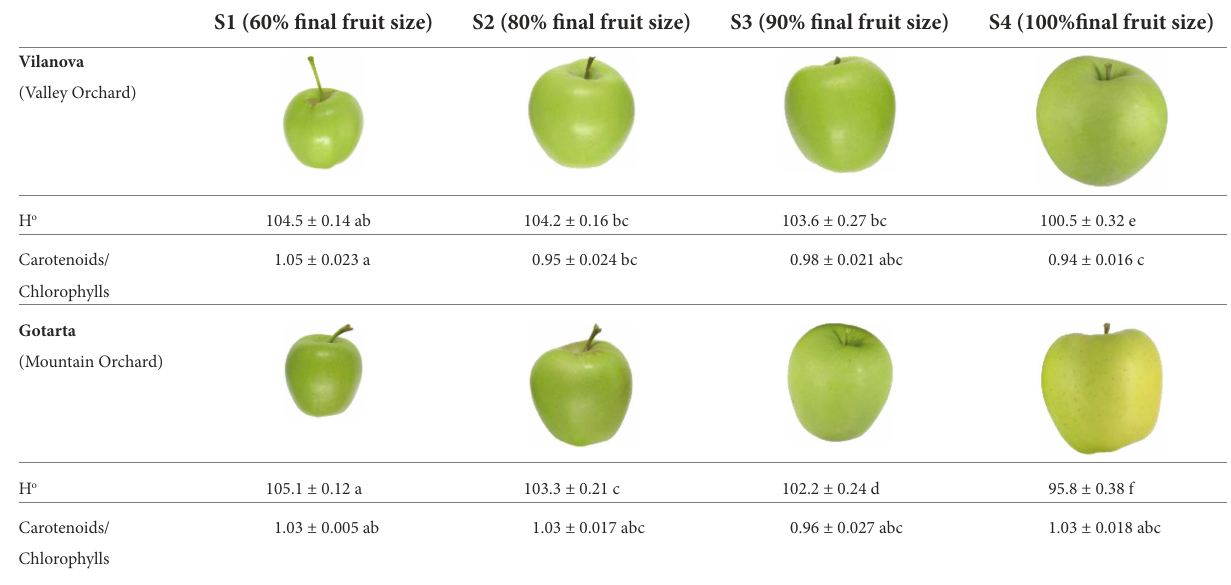
TABLE 1 Peel color evolution during the four developmental stages studied in Vilanova (valley) and Gotarta (mountain)